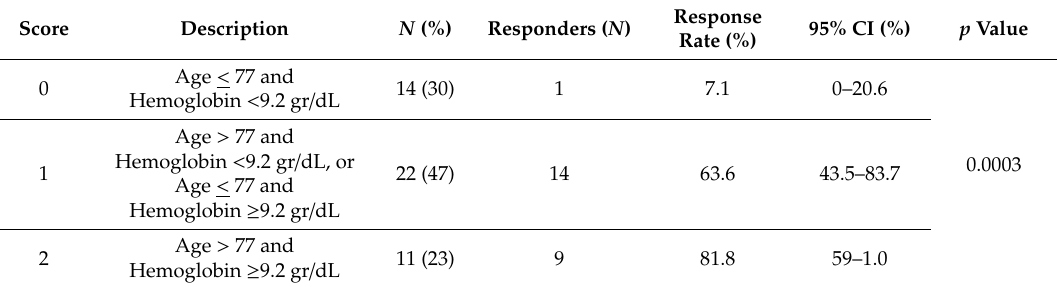
Table 4. Response rate according to score based on age and